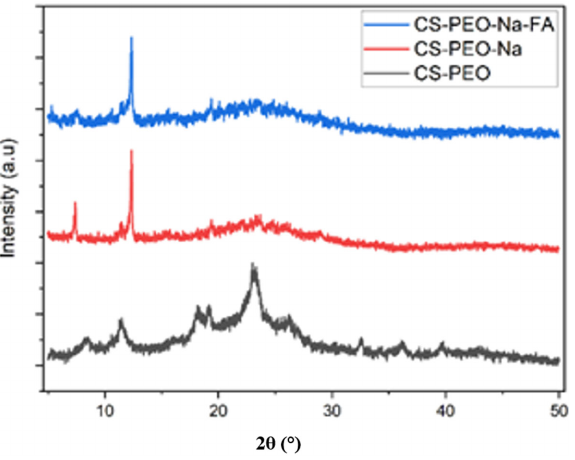
Figure 4. XRD diffractogram of SPE.